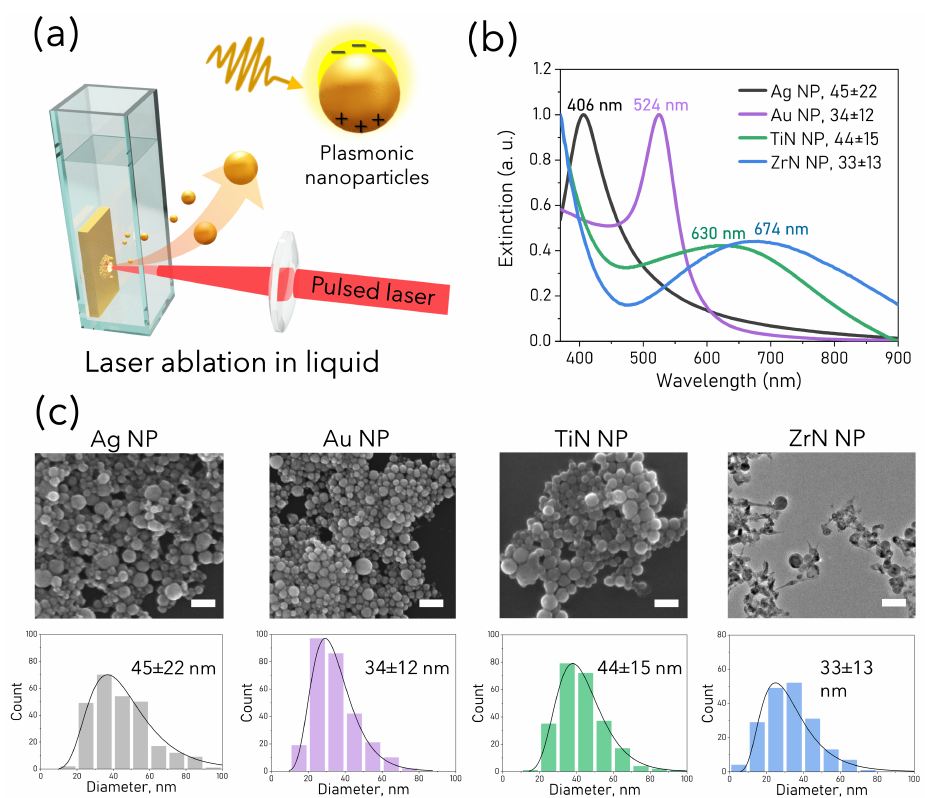
Figure 1. ( a ) Plasmonic NP synthesized by laser ablation in liquid method (LAL). ( b ) Normalized optical extinction spectra of Ag (black), Au (violet), TiN (green) and ZrN (blue) NP. ( c ) SEM images of plasmonic NP synthesized by LAL and their corresponding size distributions: Ag NP, Au NP, TiN NP, ZrN NP. Scale bar: